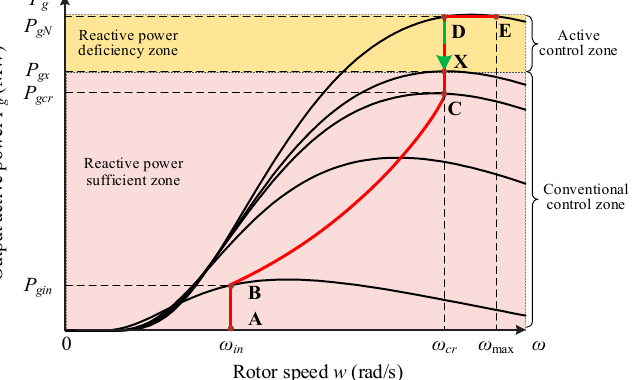
Figure 7. The power variation characteristics of DFIG with the active β control strategy based on the LRP–RPCD operation curve.